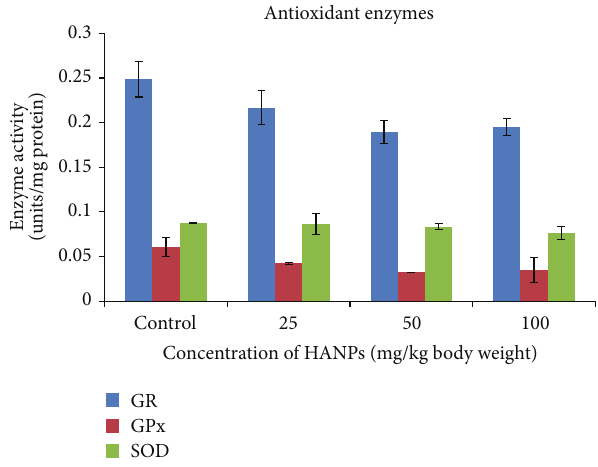
Figure 5: Activity of antioxidant enzymes in the liver of rat exposed to HANPs (mean ± SD, 𝑛 = 5